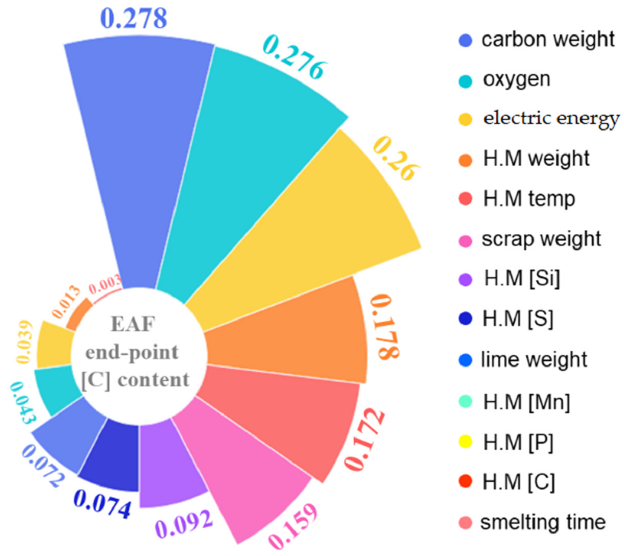
Figure 2. Correlation Analysis of the process variables.